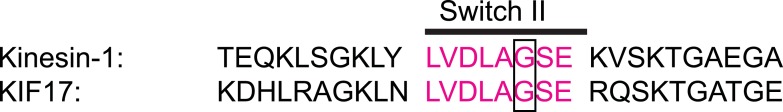
Switch II mutation in KIF17.Amino acid sequence alignment of the switch II regions of Kinesin-1 and KIF17 showing identical sequences. Switch II residues are shown in magenta with a box around the G residue mutated in the motor domain mutant.